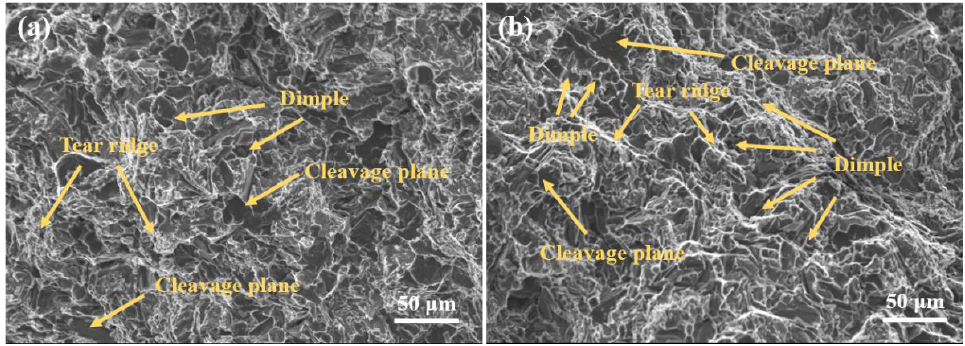
Figure 12. Tensile fracture at room temperature of B1 alloy ( a ), B3 alloy ( b ).